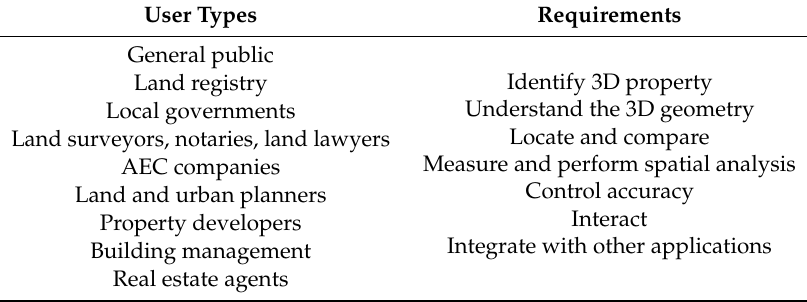
Table 1. Users and user requirements